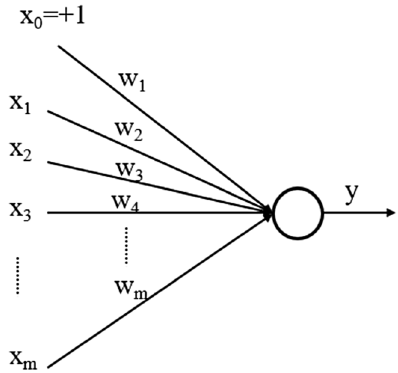
Figure 5. Diagram of an artificial neuron as building block of a ANN. For a given artificial neuron, let there be m + 1 inputs with signals x 0 through x m and weights w o through w m . The output y of the neuron acts like an input to the neurons in the next layer 42